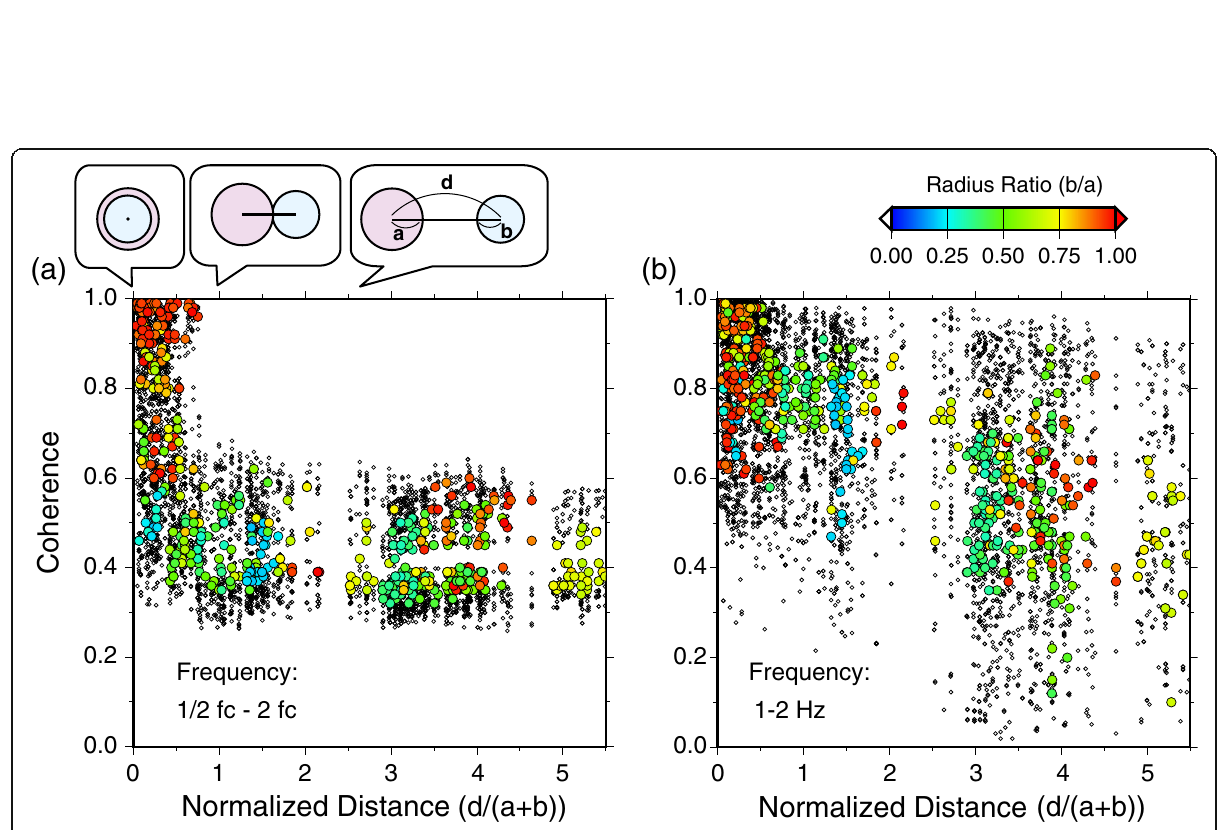
Fig. 5 Relationship between normalized distance (distance between the centroids of a pair of earthquakes divided by the summation of the source radii) and coherence for the off-Kamaishi earthquake cluster in northeastern Japan (Fig. 4a). a , b The results from the frequency range around the corner frequency of the smaller earthquake (1/2 fc – 2 fc) (Uchida and Matsuzawa 2013) and 1 – 2 Hz, respectively. Normalized distances 0, 1, and > 1 indicate identical centroids, contacting sources, and sources with no overlap as shown in top left insets. Black dots show values at each station and colored dots are values averaged for each pair of earthquakes. The color represents the radius ratio (the radius of the smaller earthquake divided by the radius of the larger earthquake). The centroid locations and source sizes used for the calculations are from Uchida et al. (2012) where the centroids are estimated by the waveform-based double-difference method and the source sizes are estimated from corner frequencies using stacked spectrum ratios. Uncertainties in the normalized distance and radius ratio are less than 0.2 and 0.12,